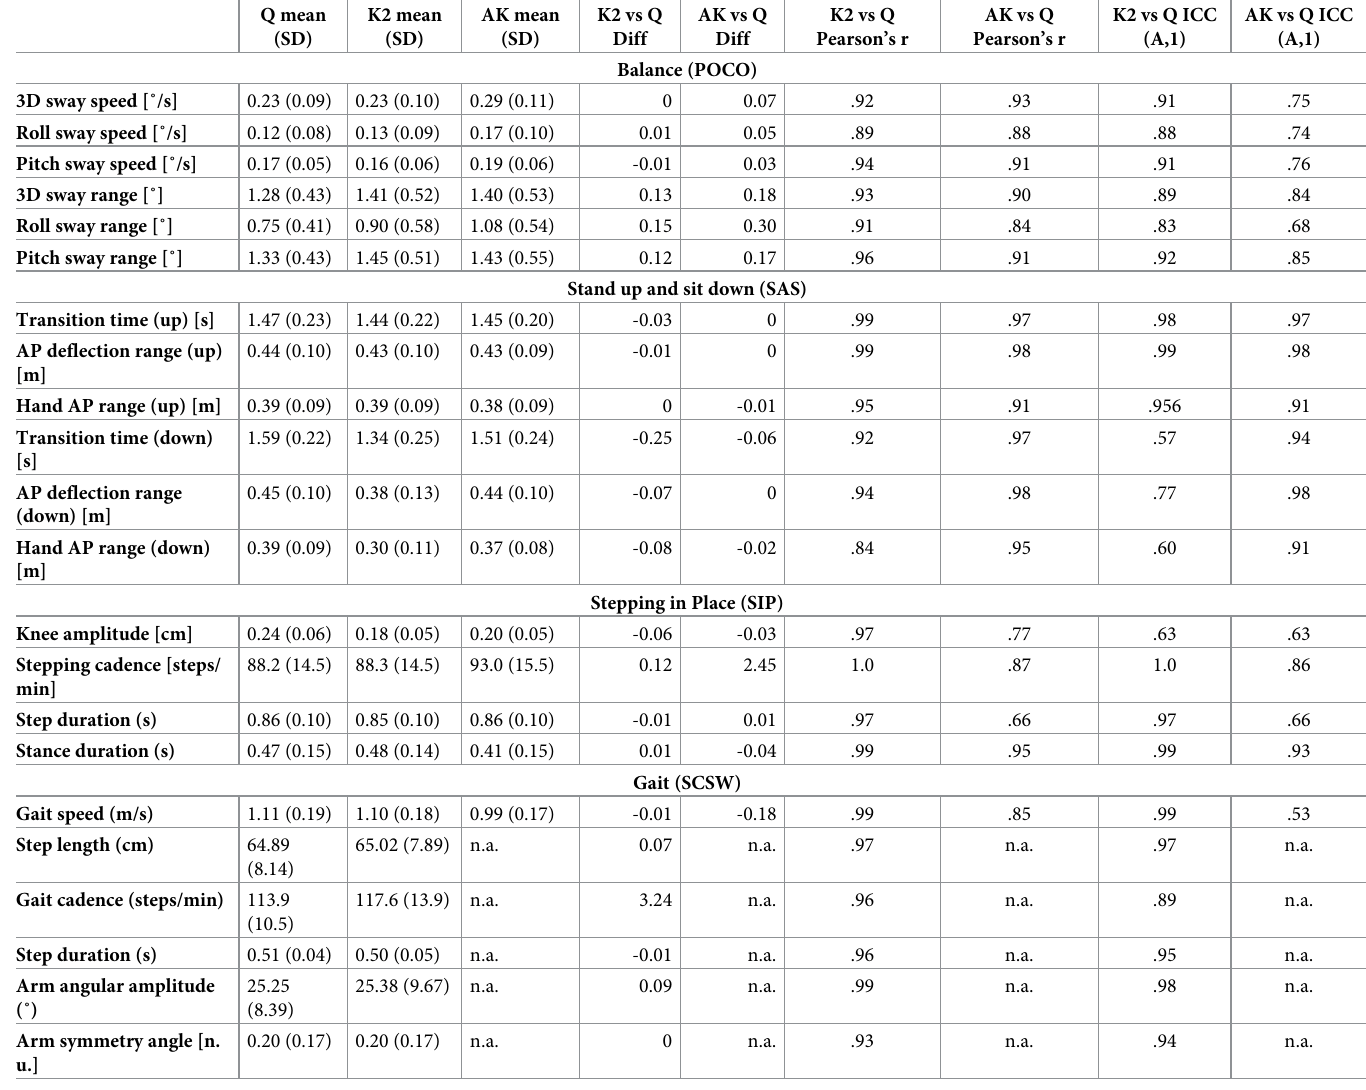
Table 5. Accuracy of parameters using only the first available measurement per